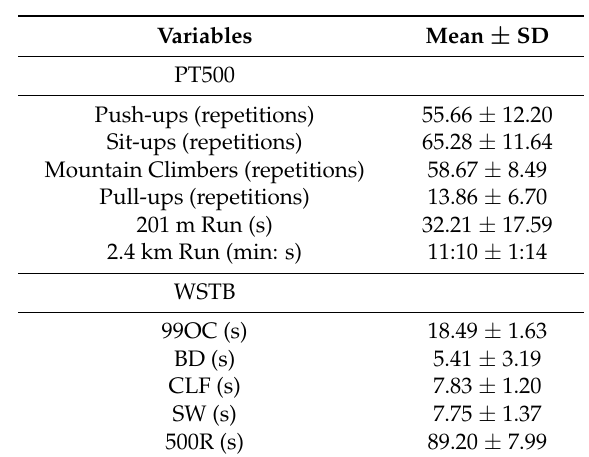
Table 1. Descriptive data for the PT500 (a battery of general fitness tests) and the work sample test battery (WSTB) in law enforcement recruits ( n =